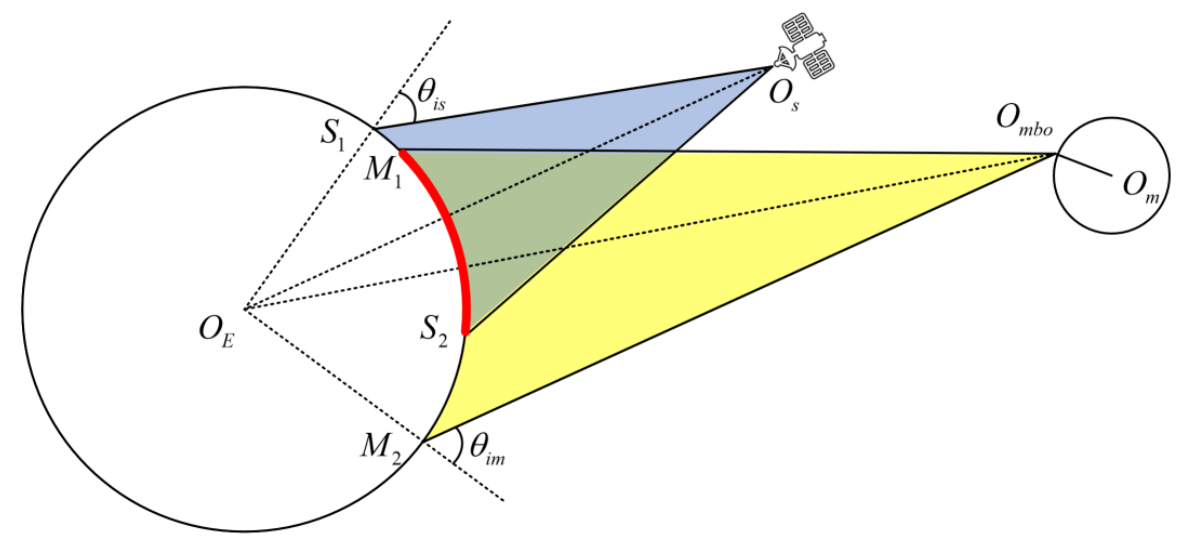
Figure 5. Simplified MS-BiSAR Earth observation geometrical model. O mbo is the Moon-based observatory, O m is the selenocenter, O E is the geocenter, and O s is the satellite. θ im and θ is are the threshold for the incidence angle of transmitter and receiver, respectively. S 1 and S 2 are the boundaries of the observable area of the satellite receiver. Meanwhile, M 1 and M 2 are the boundaries of the observable area of the Moon-based observatory. The red area is defined as the observable area of MS-BiSAR (not to scale for the sake of